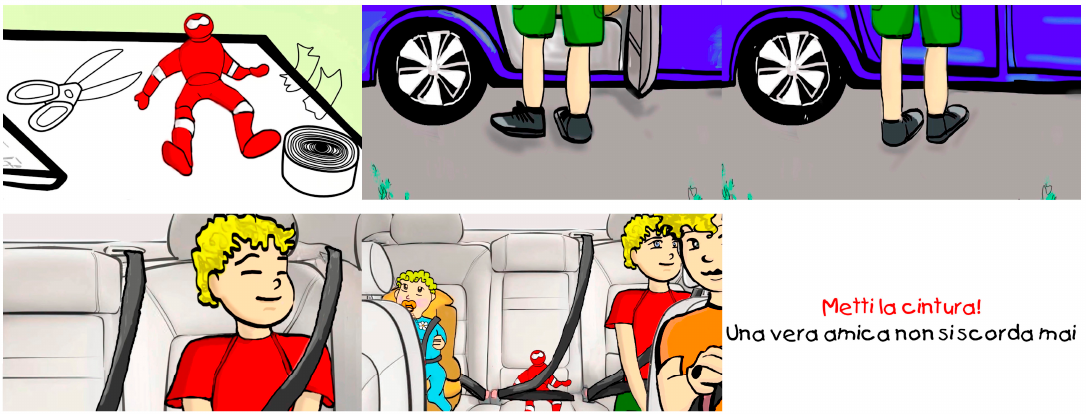
Figure 5. Frames from the project “Cintura amica”. Problem: incident on means of transport (without safety belt). Target: children 6–9 years. Technique: animation; duration 40 s. Visual column: